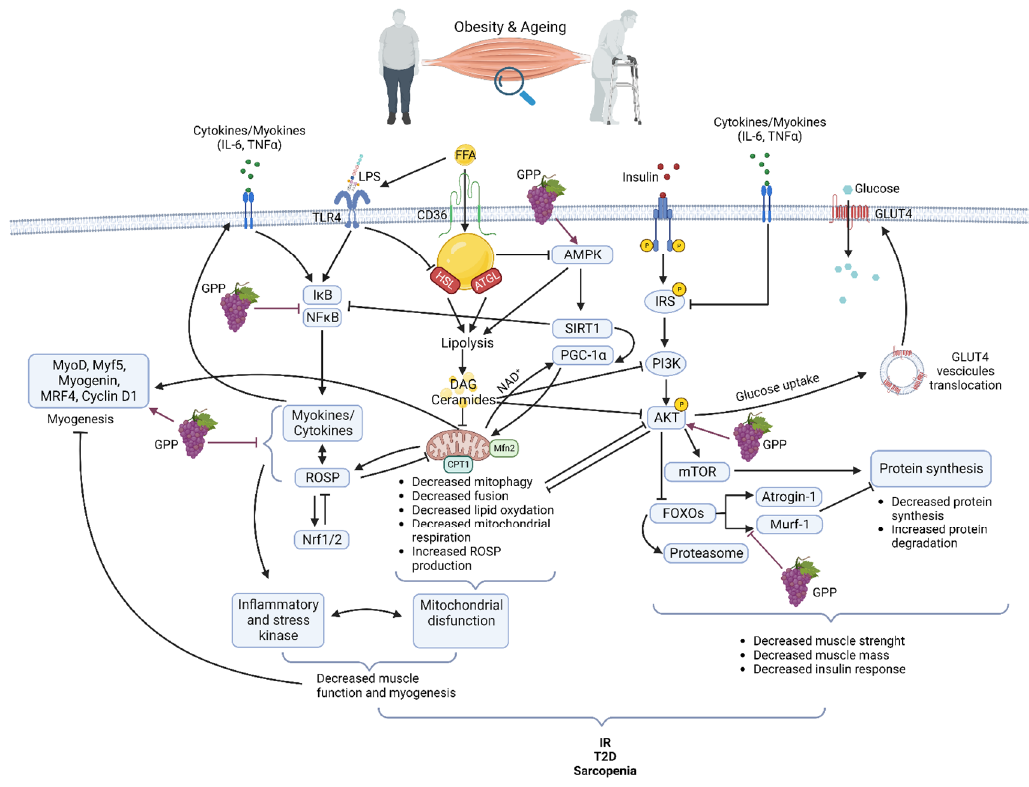
Figure 1. Main pathways involved in muscle dysfunction during obesity and aging and their mod- ifications by grape polyphenols (GPP) (Created with